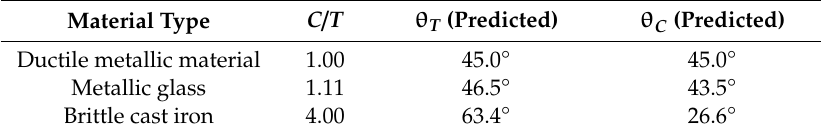
Table 2. Failure angles θ T and θ C predicted by the linear Mohr–Coulomb criterion